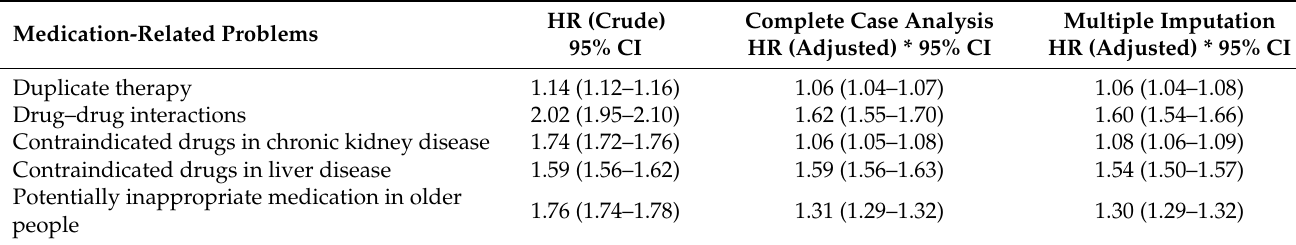
Table 4. Mortality related to medication-related problems in older people with multimorbidity at baseline year (N = 853,085). Medication-Related